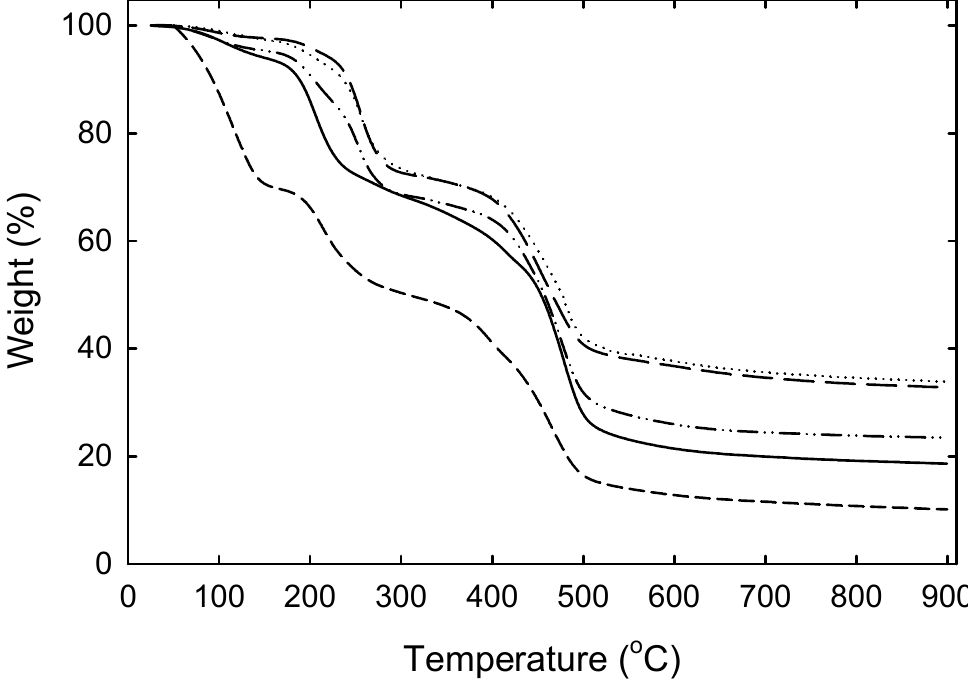
Figure 6. TGA curves of the pure resin in chloride form (—-) and those loaded with Ag NPs using increasing AgNO 3 concentrations of 1 mM (—), 10 mM (– •• –) and 50 mM (— —), and 100 mM (•••).